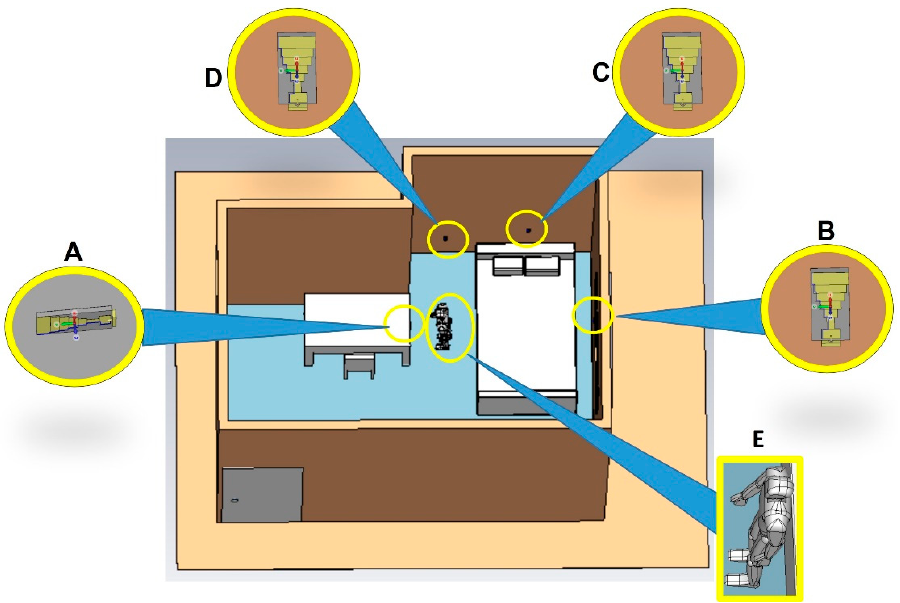
Figure 7. Digital model of the care home with unobtrusive sensor ( A ) on side of the table, ( B ) on the wall to the right, ( C ) above the bed, and ( D ) to the left of the bed; ( E ) electromagnetic human/patient model.